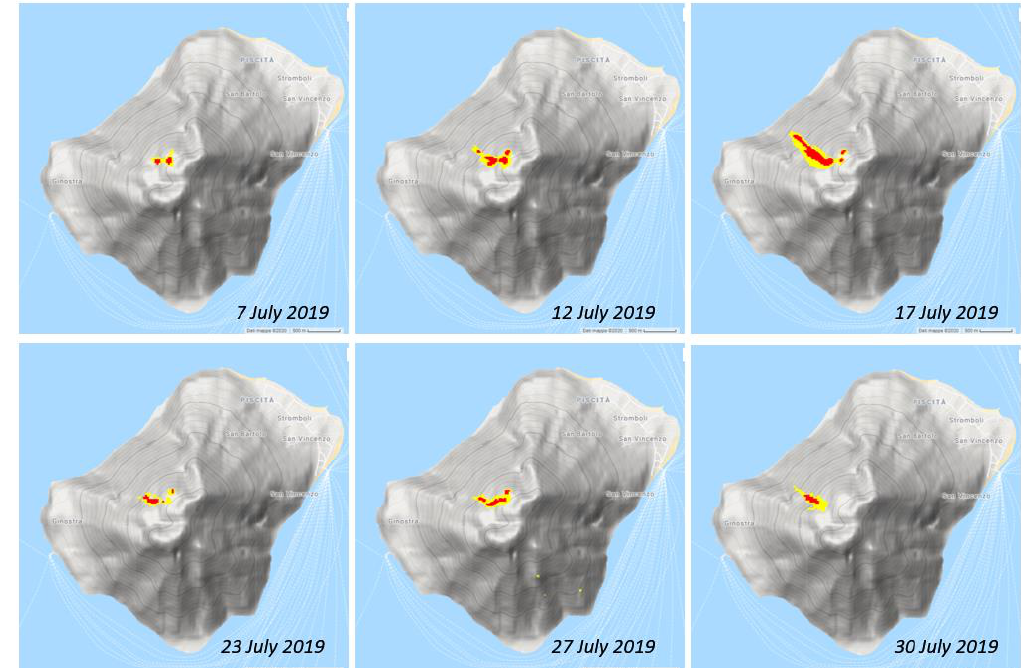
Figure 7. Thermal anomaly maps from S2-MSI and L8-OLI data of 7 − 30 July 2019, covering the Stromboli (38 °47′38″N 15°12′40″E) volcano (Italy), generated by means of the NHI tool (v.1.4).